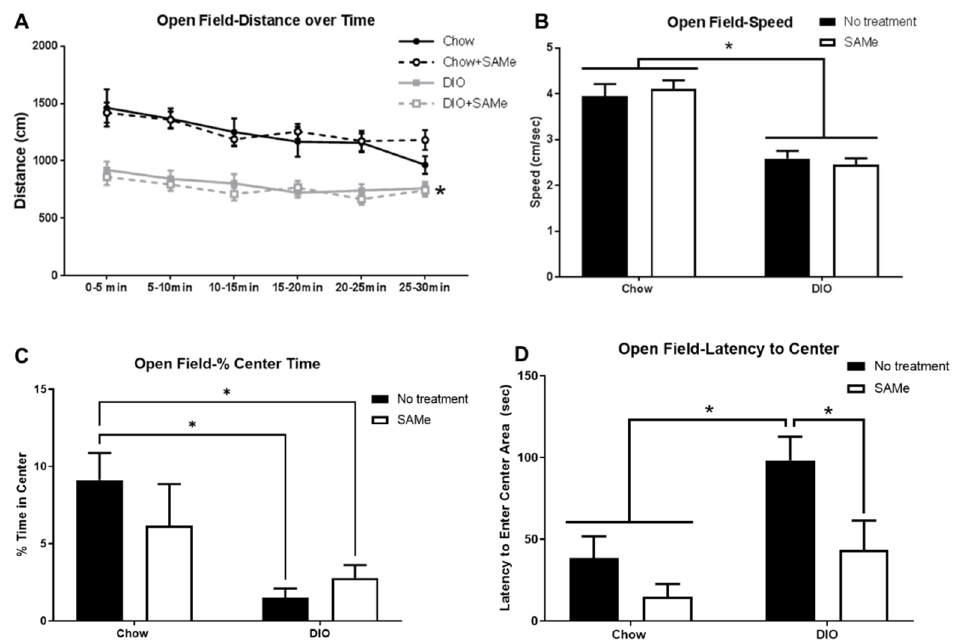
Figure 4. ( A ) DIO mice placed in the open field were less mobile than their Chow counterparts ( n = 12–15/group), there was no effect of SAMe. ( B ) DIO mice did not move as quickly as Chow mice, SAMe did not affect speed. ( C ) DIO mice spent a lower percentage of their time in the center of the open field than untreated Chow mice. ( D ) SAMe treatment improved latency to enter the center area of the open field in DIO mice. *: Significant difference.